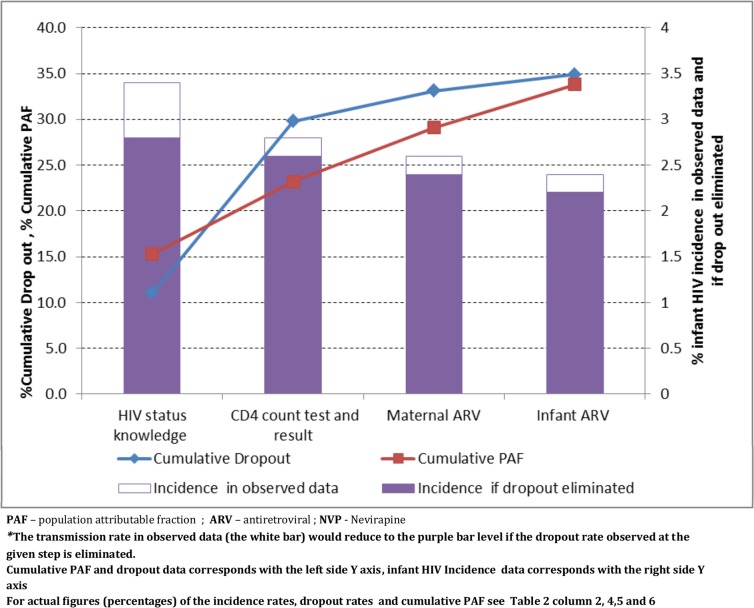
The increase in cumulative PAF as cumulative dropout rate increases (red and blue lines), and reduction in infant HIV incidence if dropout is eliminated (purple bar*).